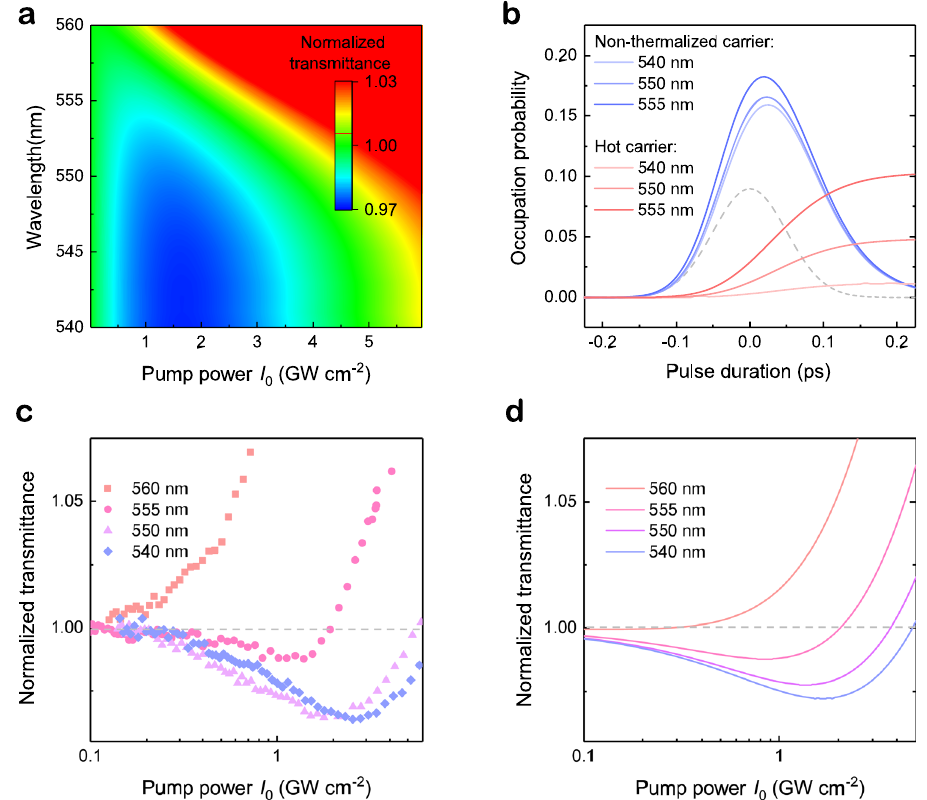
Fig. 5 | Mathematical simulation of carrier kinetics and nonlinear absorption. a Calculated pseudocolour representation of the NLA mapping as a function of pump power and laser wavelength. b Occupation possibility evolution of non- equilibrium carrier and hot carrier under a pump fl uence of 0.6mJ cm − 2